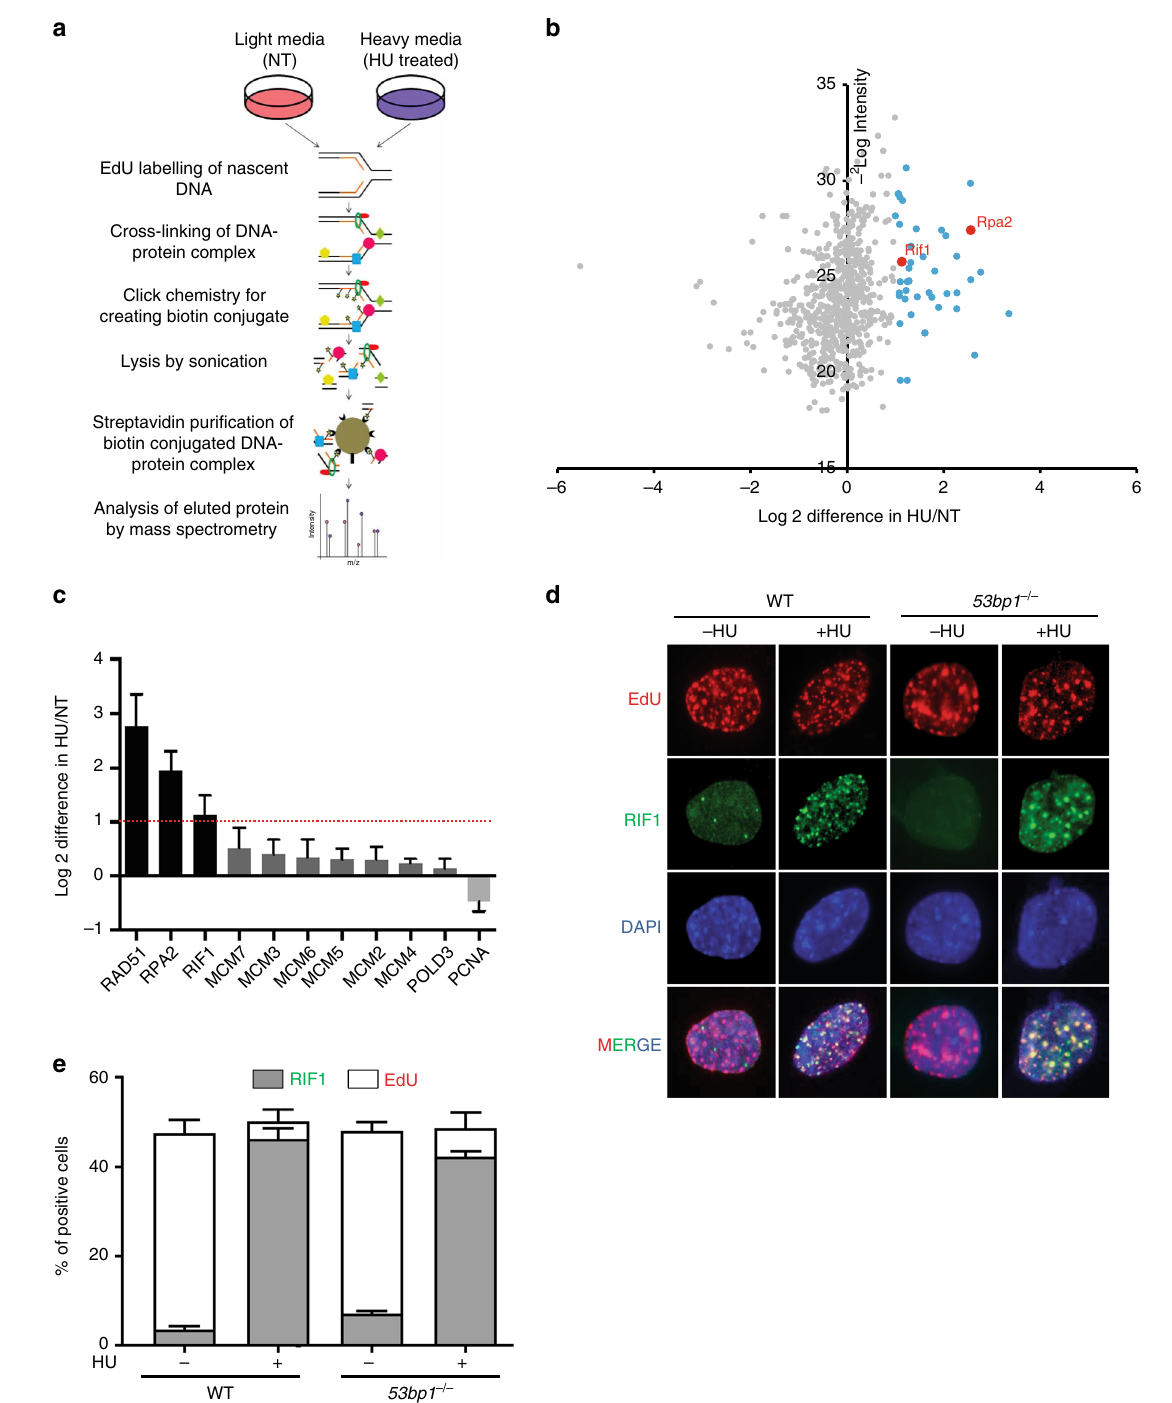
Fig. 1 RIF1 is recruited to the stalled replication forks. a Schematic representation of iPOND experiment. b Volcano plot showing the results for average fold-change to identify signi fi cantly upregulated proteins upon HU treatment based on H:L ratio in the SILAC experiment. The x -axis ('2Log Difference HU/NT) represents the fold upregulation. Data points in blue represent proteins that are upregulated >2-fold; RIF1 is indicated in red. c Bar graph showing fold upregulation of a selection of proteins upon HU treatment based on their SILAC H:L ratios (error bars represent standard deviation). d Representative micrographs showing co-localization of RIF1 (green) to sites of DNA replication as marked by EdU (red) in the presence or absence of HU in WT and 53bp1 − / − cells. Nucleus was stained with DAPI (blue). e Quantitation of d showing the percentage of cells, which show co- localization between EdU and RIF1(error bars represent standard